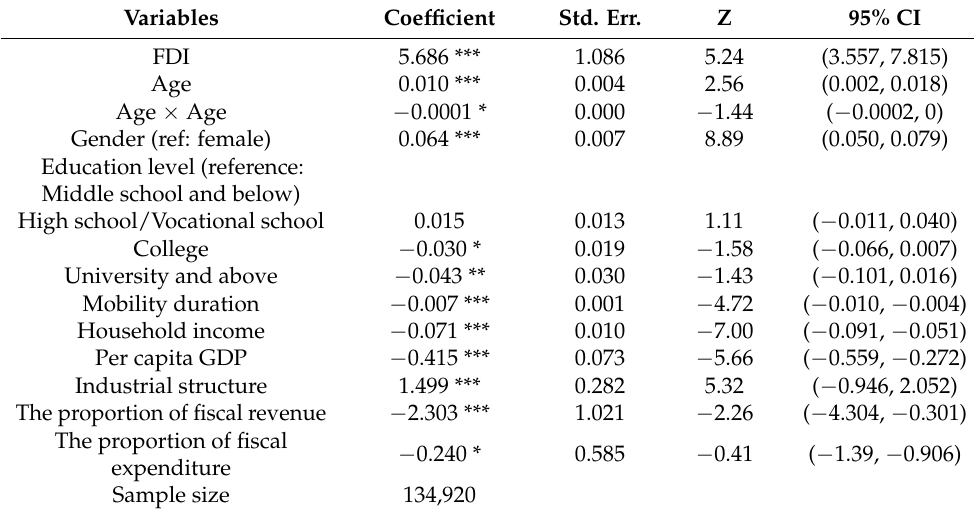
Binary probit model regression analysis of FDI influencing rural-urban migrants’ physical